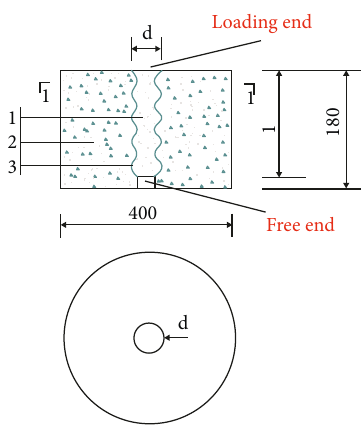
Figure 2: Specimen size (unit: mm). 1—grout; 2—concrete; and 3—plastic